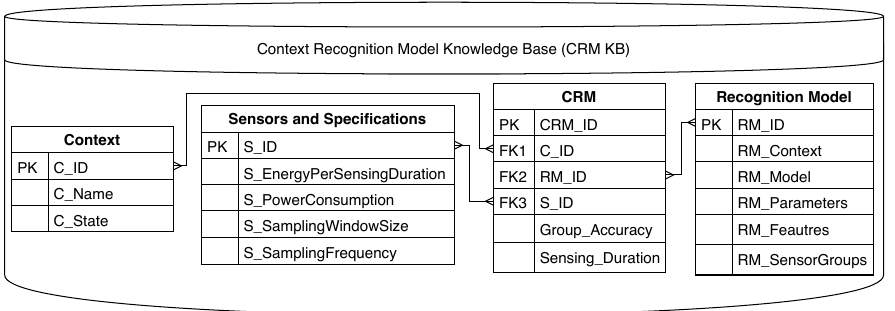
Figure 2. The context recognition model knowledge base (CRM KB), containing the information relevant to context recognition: (1) context; (2) sensors and specifications; (3) recognition